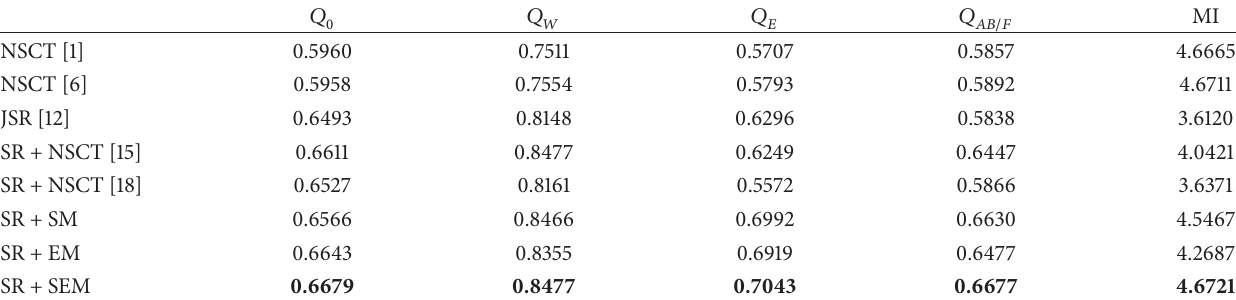
Table 1: The objective evaluation and running time for CT and MR image fused results of all